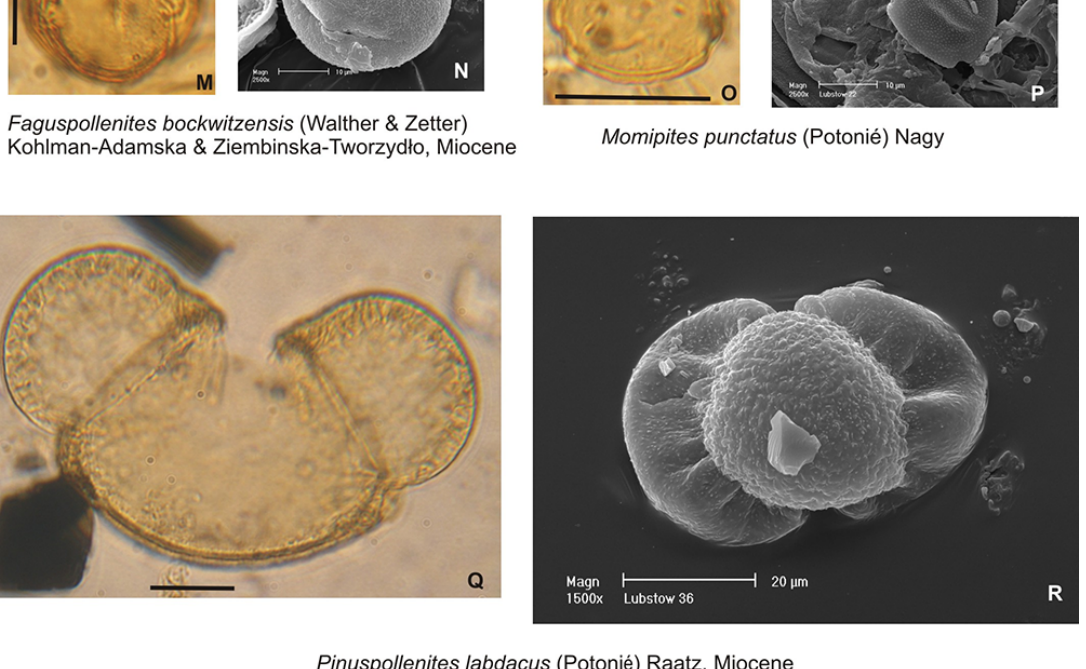
Figure 9 Pollen grains from the Tertiary sediments. ( A,C,E,G,I,K,M,O,Q ) Photo: B. Słodkowska. Scale bar 20 μm. ( B,D,F,H,J,L,N,P,R ) Scanning electron microscopy (SEM) images. Photo: M. Ziembińska-Tworzydło. Scale bars in the photos.